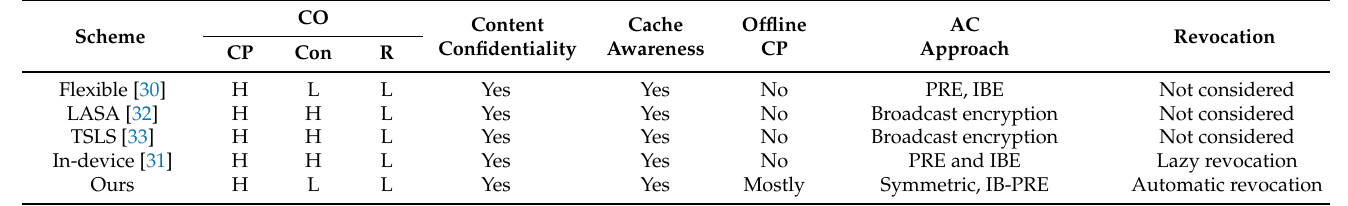
Table 4. Comparison with related access control